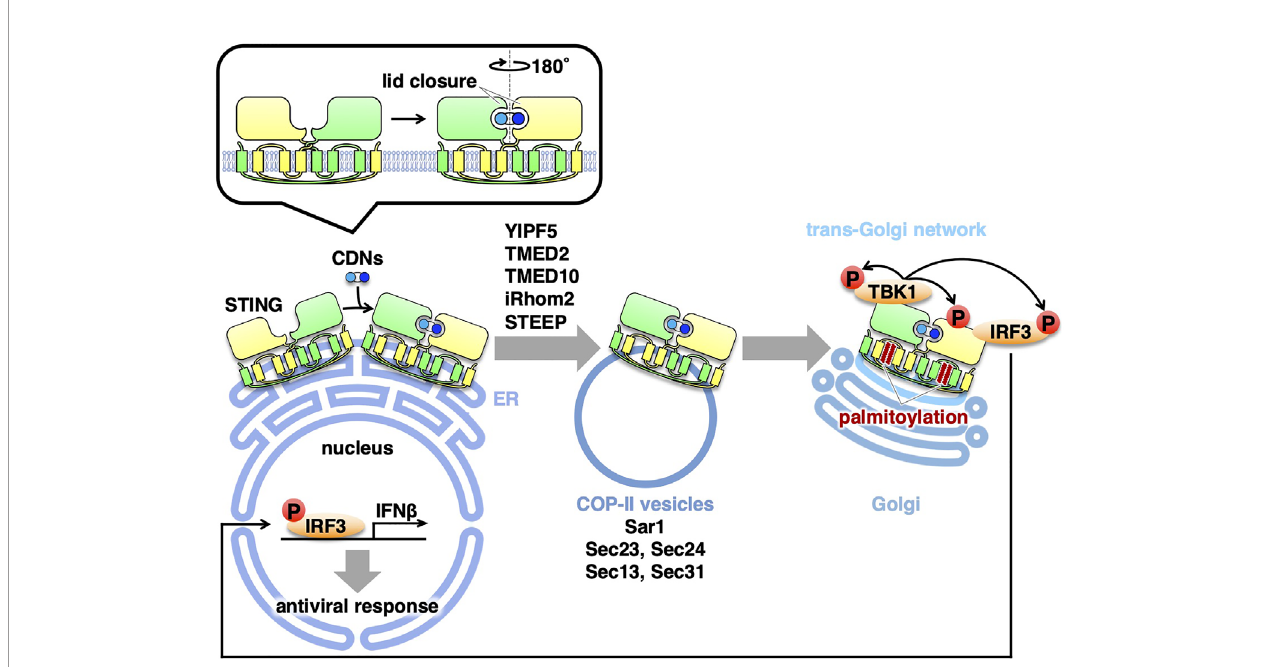
FIGURE 1 | Exocytic membrane traf fi c of STING from the ER. STING localizes at the ER at the steady-state. Upon binding to CDNs, STING translocates from the ER to the Golgi with COP-II vesicles. Several proteins (YIPF5, TMED2, TMED10, iRhom2, and STEEP) associated with the COP-II components are required for the translocation of STING. After reaching the Golgi, STING undergoes palmitoylation and activate TBK1 at the trans-Golgi